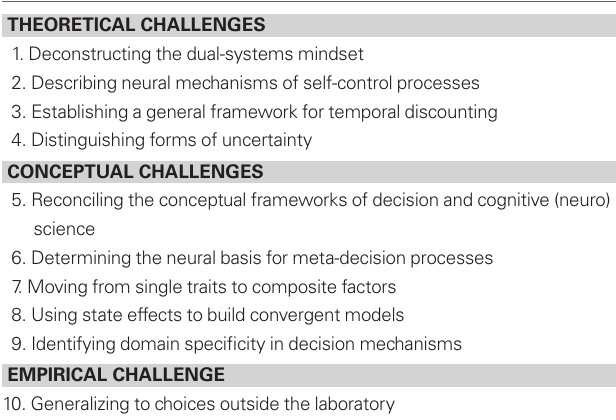
Table 1 | Challenges for decision